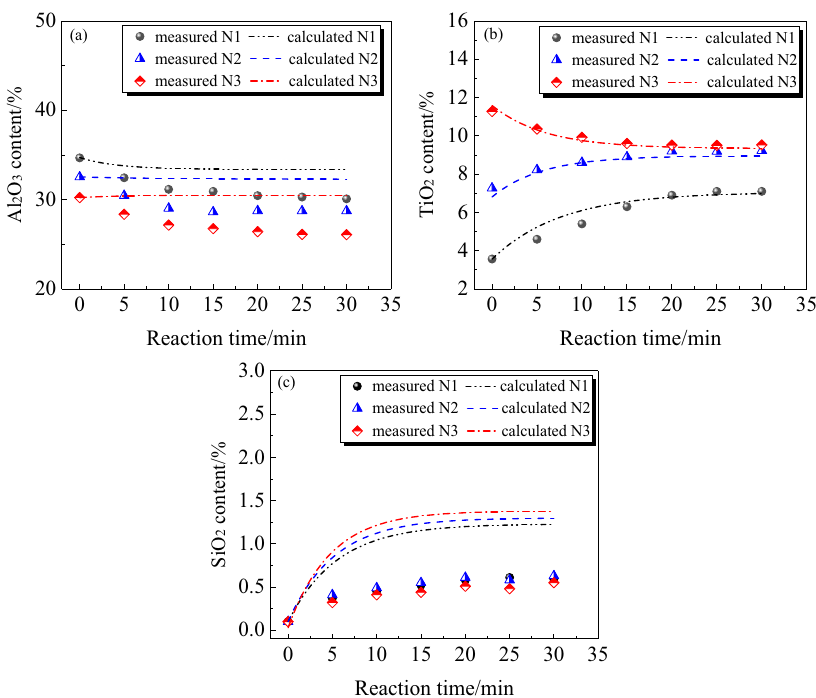
Figure 6: Changes of Al 2 O 3 , TiO 2 , and SiO 2 content in the slag: ( a ) Al 2 O 3 , ( b ) TiO 2 , and ( c ) SiO 2 .